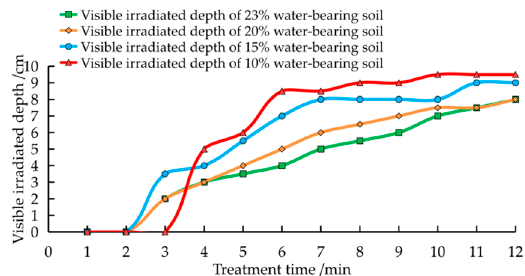
Figure 35. Visible drying depth of Northeast black soil.